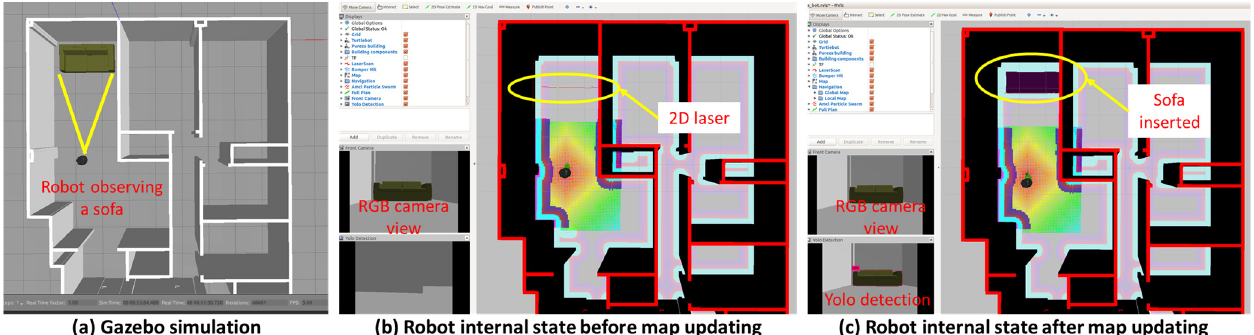
Figure 8. Example of object recognition and navigation map updating. ( a ) Robot observing a sofa in a Gazebo simulation, ( b ) robot’s internal state before map updating, and ( c ) robot’s internal state after map